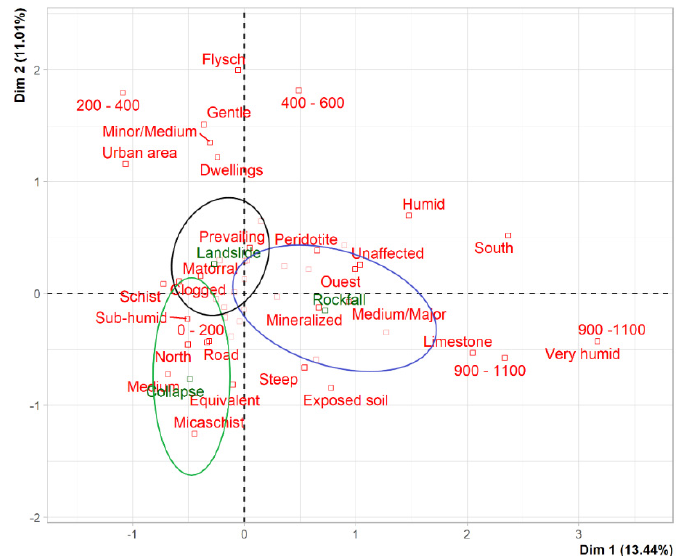
Figure 8. Graph of MCA modalities.